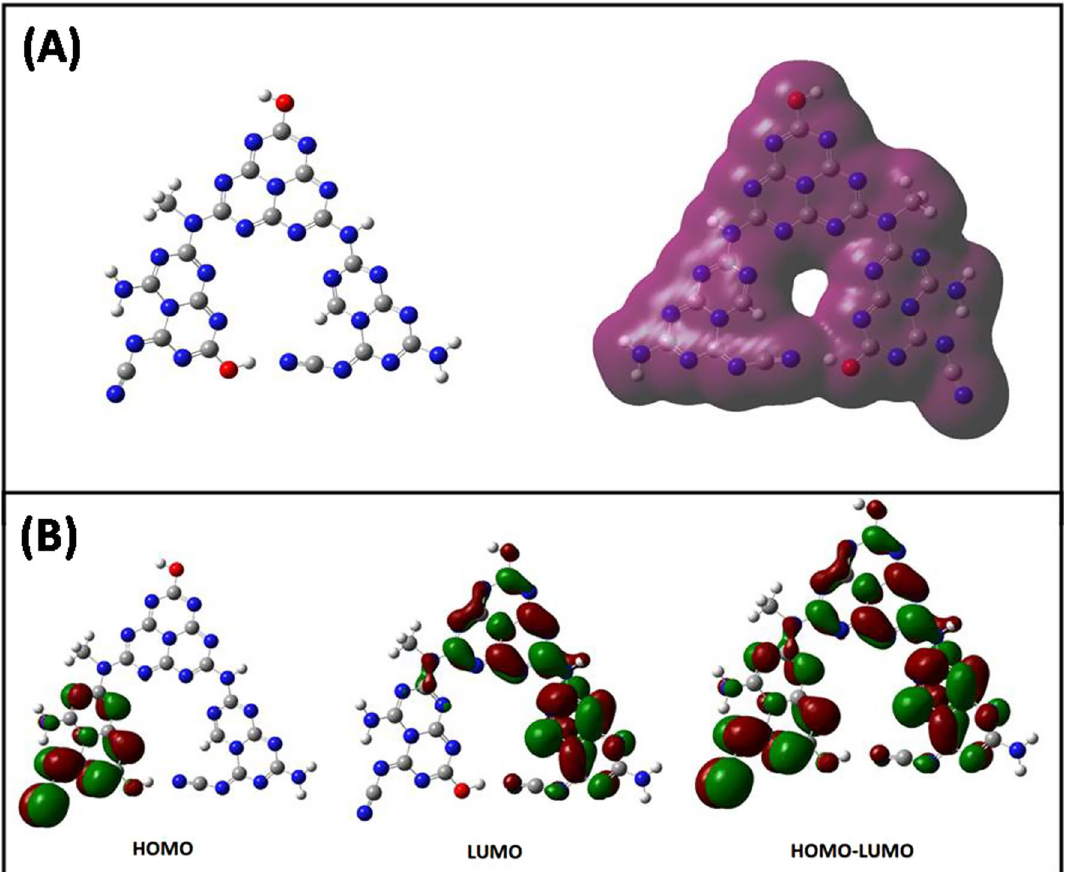
Fig. 1 A The optimum geometry and electrostatic potential map for structure. B Spatial distribution of calculated HOMO and LUMO orbitals of the synthesized T/G‑C 3 N 4